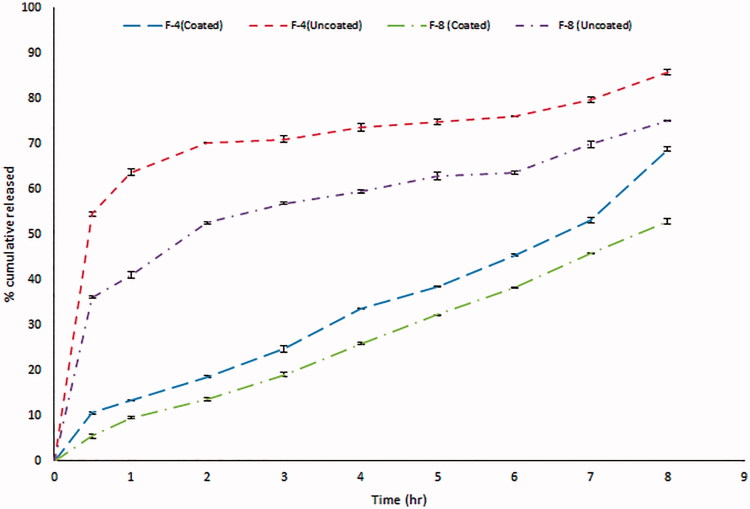
In vitro release profile of GBP before and after coating with Eudragit NE 30D.